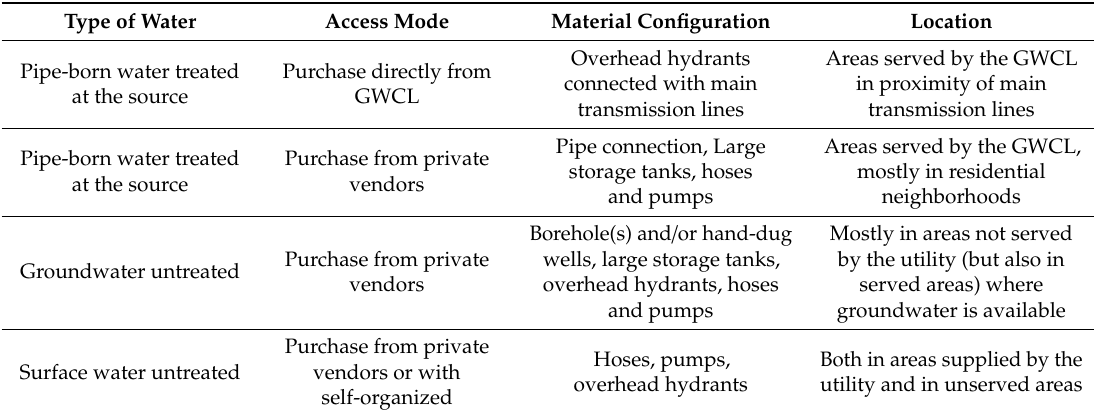
Table 2. Main characteristics of water sourcing arrangements. Source: authors’ fieldnotes,